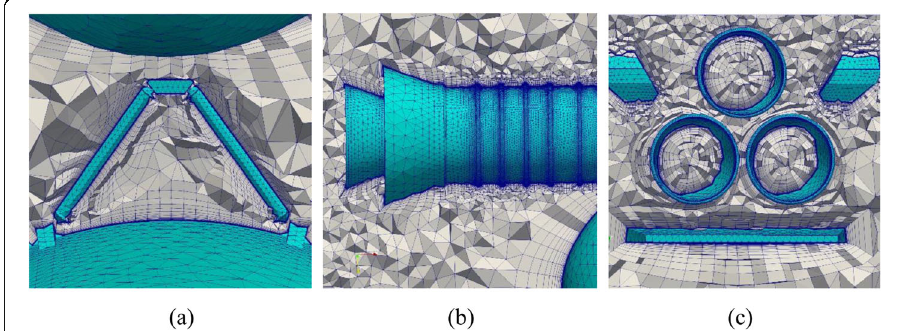
Fig. 10 Local details of boundary layer meshes of the space shuttle aircraft. ( a ) Boundary layer meshes around the support between the plane and rocket; ( b ) Boundary layer meshes around the top view of rocket; ( c ) Boundary layer meshes around space shuttle